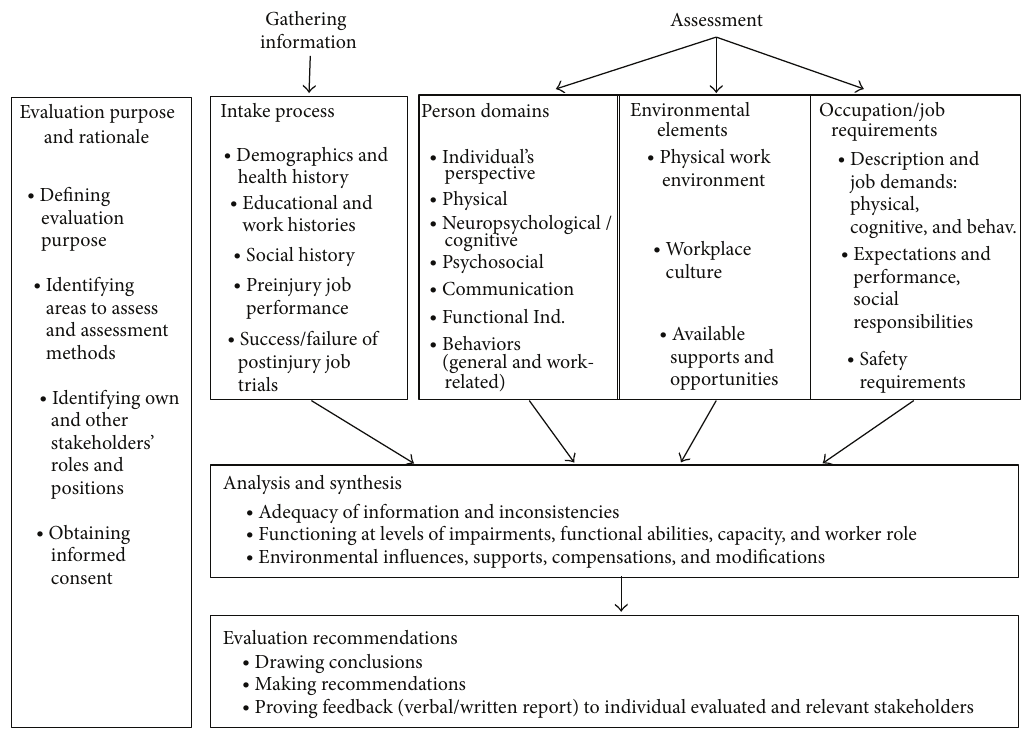
Figure 1: Evidence-based framework for vocational evaluation following TBI. This figure was reprinted with kind permission from Springer Science and Business Media. Note: reprinted with permission CCO license number 3697230252812. The figure was originally published in [52].